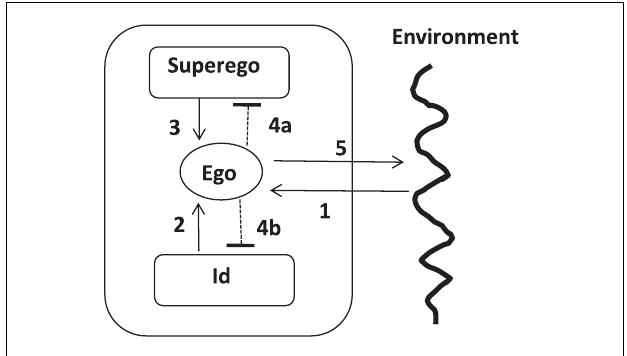
FIGURE 8 | Block diagram of the implicit cyber-systemic structure of the structure